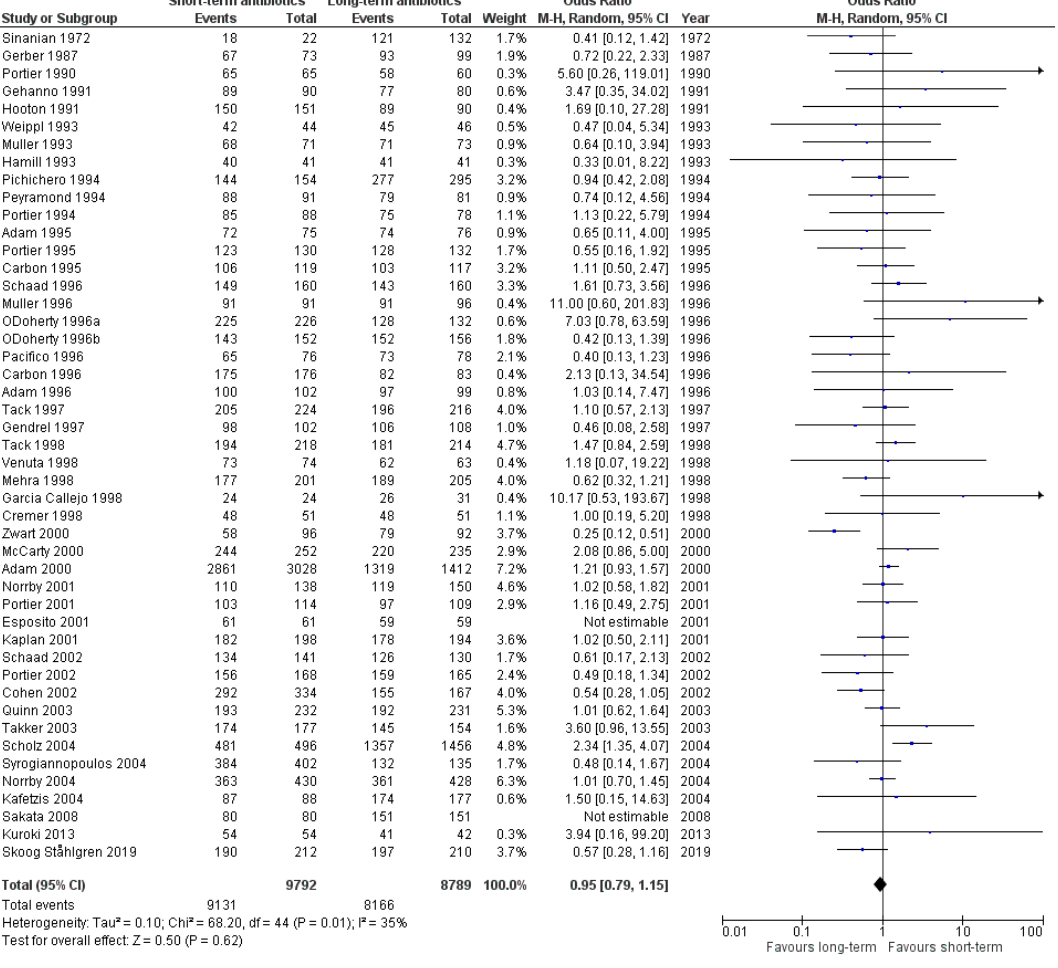
Figure 3. Early clinical cure of short-term antibiotic therapy compared to long-term regimen treatment.